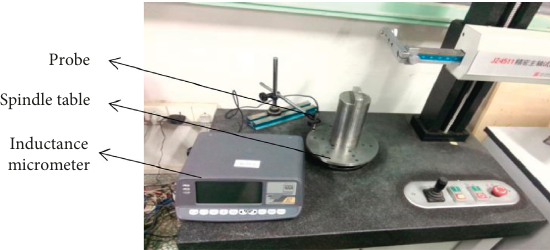
Figure 12: Measurement system of aerostatic bearing static stiffness.